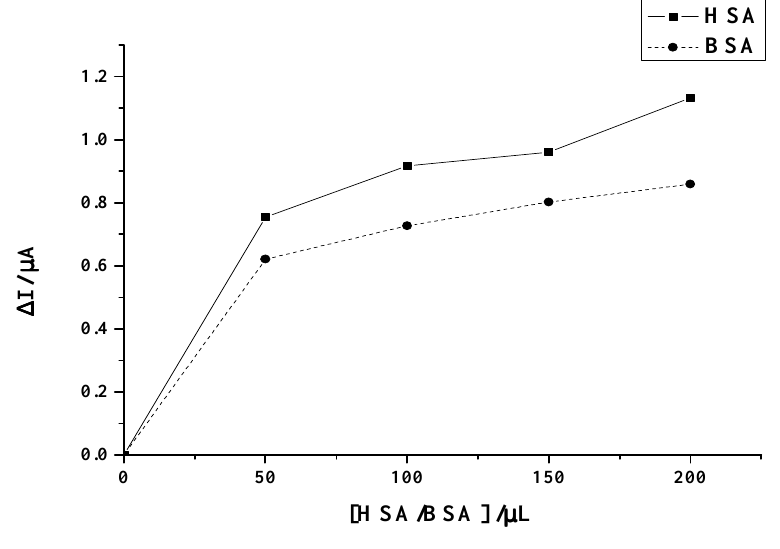
Figure 7. Plot of the decrease of the camptothecin peak current versus the addition of different volume of HSA/BSA in the solutions. HSA/BSA concentration: 10 mg/ml (1.52×10 -4 M). Others same as